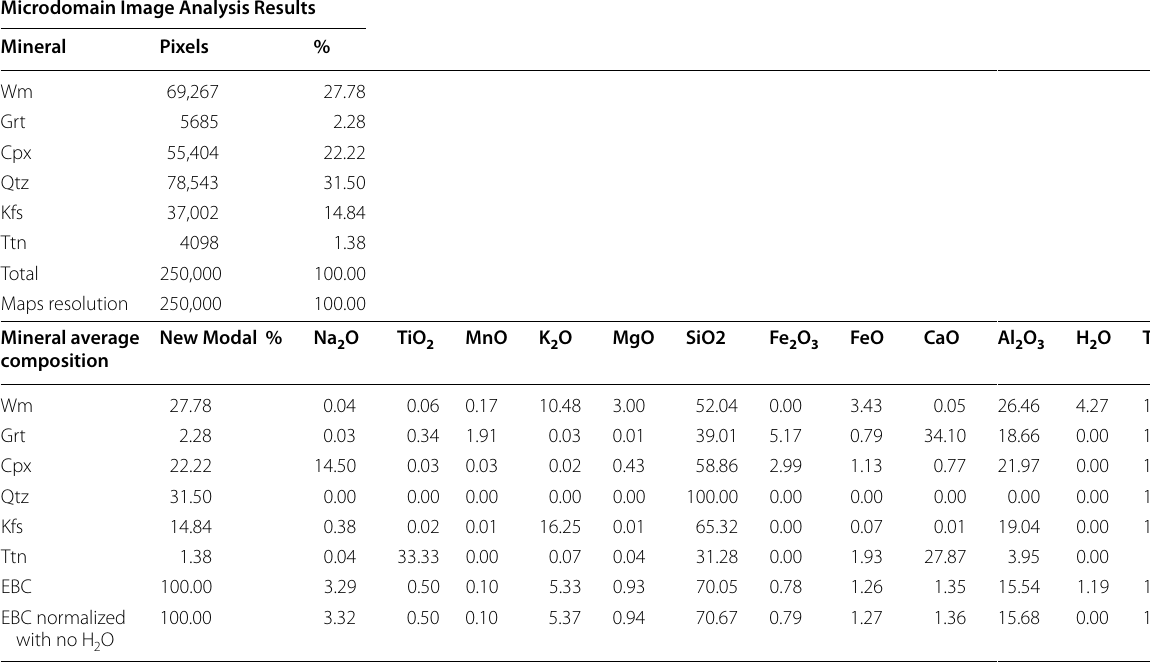
0.40.60.81.01.21.4 Fig. 13 a PT conditions of D1 (blue) and D2 (green) events (Table 8) estimated from quantitative image-assisted calibrated independent thermometers and barometers for garnet-bearing gneiss. b Pseudosection calculated in the Na 2 O–TiO 2 –MnO–K 2 O–MgO–FeO–Fe 2 O 3 –CaO–Al 2 O 3 – SiO 2 –H 2 O system for Grt-bearing gneiss and PT conditions of D1 (blue) and D2 (green) events (Table 8) estimated from the intersections of garnet end-members isopleths (i.e., almandine-black; grossular-white; pyrope-blue; andradite-green). The assemblage lists are reported in the Additional Table 11 Definition of the ERV and calculation of the EBC of the orthogneiss (ZR19) Microdomain Image Analysis